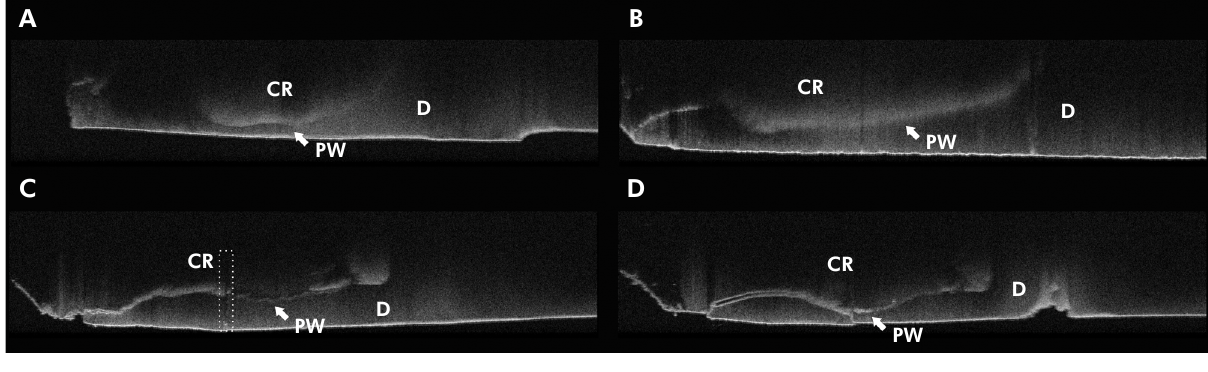
Figure 4. Representative images showing the interface between the bottom of the composite resin and the pulp wall of the cavity after the fracture resistance test. Intact interfaces for non-selective (A) and selective (B) carious tissue protocols. (C) Note the crack throughout the dentin and composite resin (inside the rectangle with dashed white lines) for a specimen with selective carious tissue removal. (D) Composite displacement in a specimen with selective carious tissue removal. CR – composite resin; D – dentin; and PW – pulpal